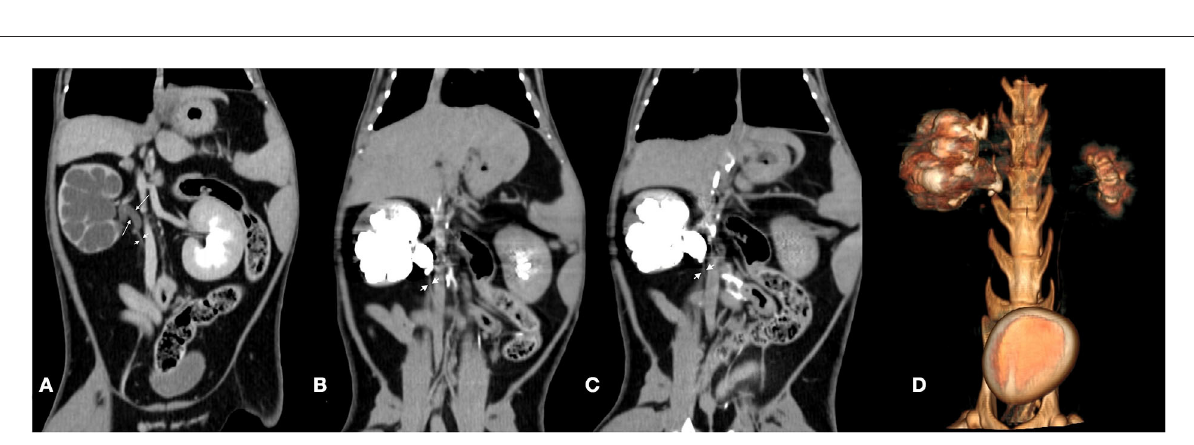
FIGURE3 Dorsal oblique MPR post-contrast reconstructions and 3D volume rendering image of the abdomen before and after the antegrade pyelography. (A) Before the antegrade pyelography, the dilated right proximal ureter (long arrow) and taper distal ureter (short arrow) was detected. (B) 0min after the puncture. (C) 5min after the puncture. Distal ureter was not filled with contrast material and tapered (short arrow). (D) 3D volume rendering image showed the shapes of renal pelvis after the antegrade